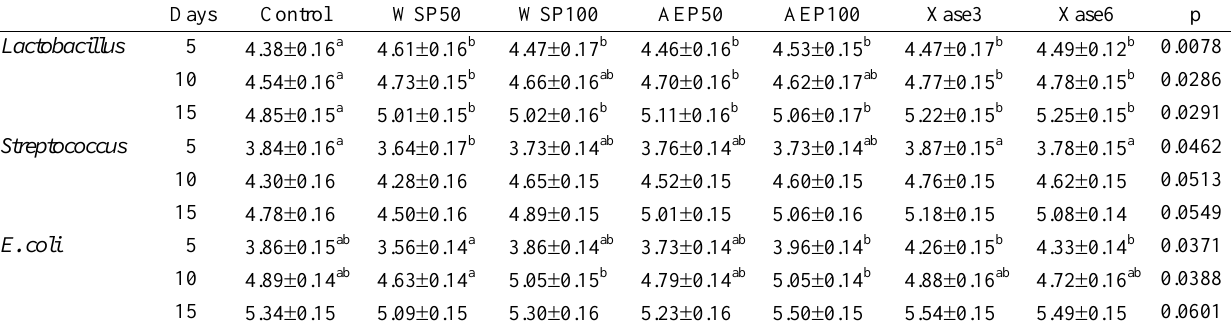
Table 4. Effects of pentosans and xylanase on the microflora in the gut (Log10